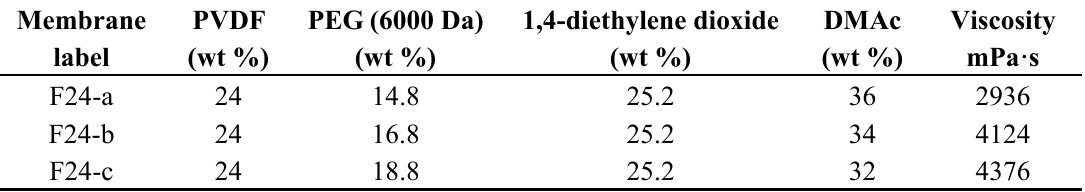
Table 1. The preparation conditions for solution-cast membranes. PEG = Polyethylene glycol.